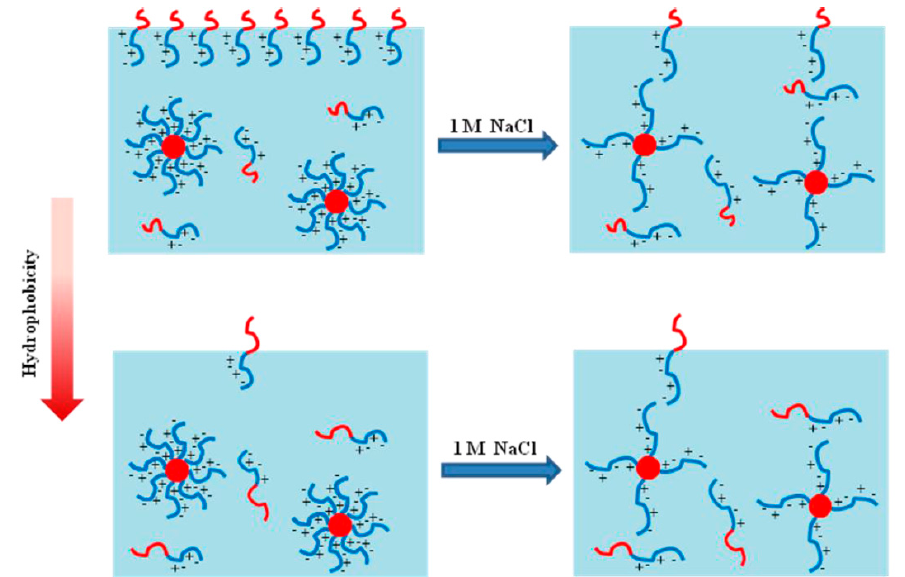
Figure 8. Schematic illustration of influence of hydrophobicity and salt on the air–water interfacial and micellization properties of ZABCs having P( n -BMA) and PEHA. Blue and red curves respectively indicate zwitterionic and hydrophobic polymers. Hydrophobic core of the micelles are represented by red circles or balls.